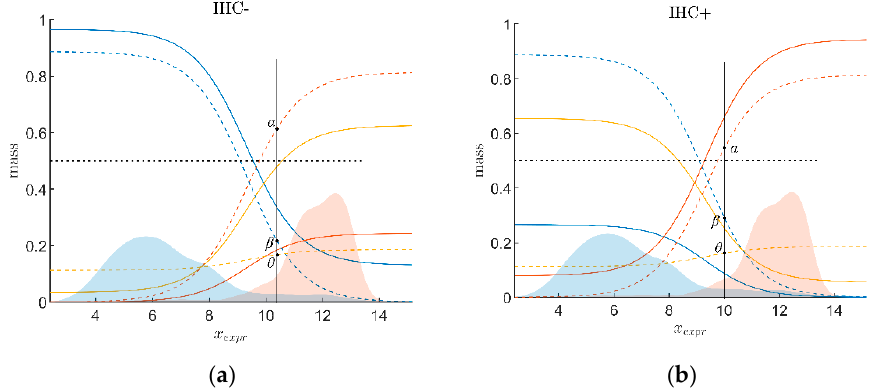
Figure 3. Combining receptor gene expression and IHC. Taking the estrogen receptor as an example, we demonstrate the principles of combining evidence from gene expression and IHC by the Yager evidence combination rule. ( a ) For IHC-negative estrogen receptor status. ( b ) For IHC-positive estrogen receptor status. Dotted lines represent beliefs merely based on gene expression, without considering IHC estimates (identical to the beliefs in Figure 2). Beliefs for gene expression combined with IHC estimates (via Yager evidence combination rule) are shown in solid lines. Clearly, a negative IHC estimate ( a ) strengthens the belief in negative (solid blue runs above dotted blue) and weakens the belief in positive (solid red runs below dotted red) for a given expression value, x Expr . As opposed, a positive IHC estimate ( b ) strengthens the belief in positive (red) and weakens the belief in negative (blue).